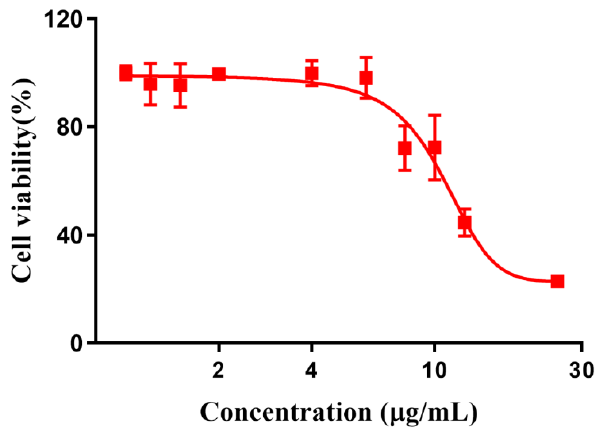
Figure 4. Cytotoxicity of Ru(II)-coumarin complexes.